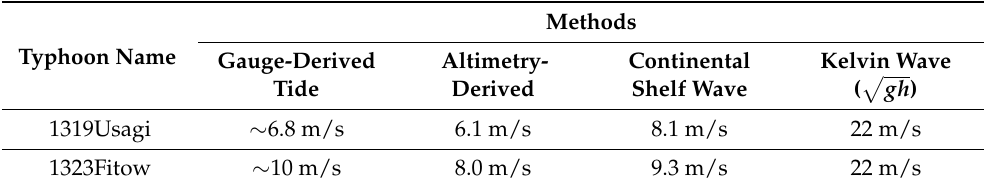
Table 2. Estimates of storm surge propagation speeds for Typhoons 1319Usagi and 1323Fitow using different methods.